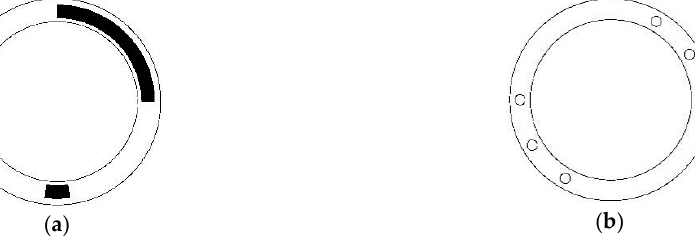
Figure 6. Disc pattern and reading head distribution of absolute encoder using a length-6 period-48 triplet-necklace ordering STGC: ( a ) Schematic of the coding disc, where the white area indicates “0”, and the black area indicates “1”; ( b ) Schematic of the reading disc, where the six small circles denote the six reading heads, and the sub-cycle of the head interval is three.